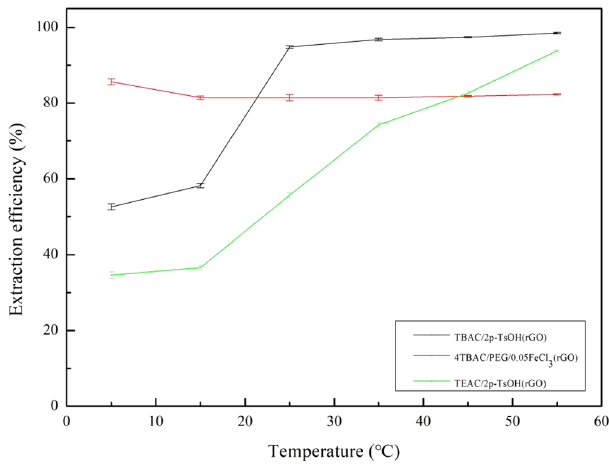
Figure 7. The effect of system temperature on the extraction efficiency (experimental conditions: 1.2 g composite material, 0.5 g simulated oil (1600 mg/L sulphur content), 800 rpm, 60